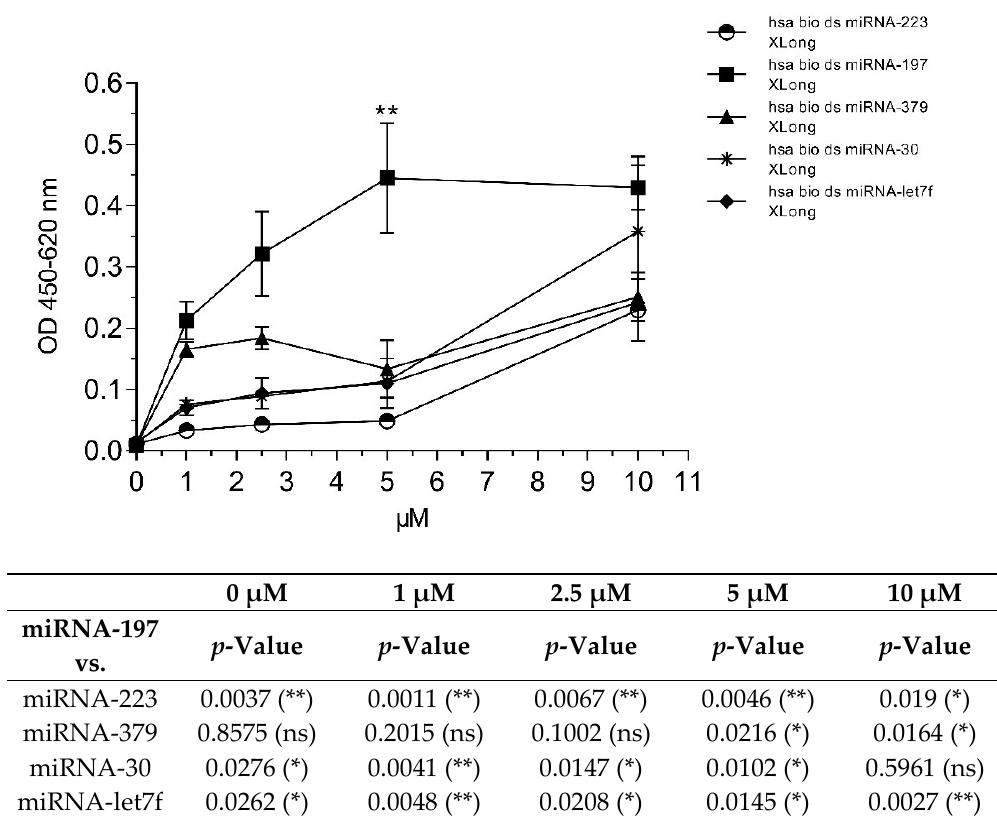
Figure 11. ELISA for the investigation of binding specificity to different repetitive extended hsa ds miRNAs conjugated with biotin. L19 (25 µg/mL) was coated onto the solid phase and incubated with five concentrations (0, 1, 2.5, 5, and 10 µM) of miRNAs (hsa bio ds miRNA-223, -197, -379, -30, and -let7f XLong. The concentration of 0 µM miRNA served as the negative control for the proof that neither the blocking solution nor the detection reagent SAV-HRP was bound by L19. The detection of bound miRNA was performed with HRP-labeled SAV. The statistical significances between the concentrations compared to miRNA-197 were determined by an unpaired t -test with ns p > 0.05, * p ≤ 0.05, ** p ≤ 0.01 (n = 4).